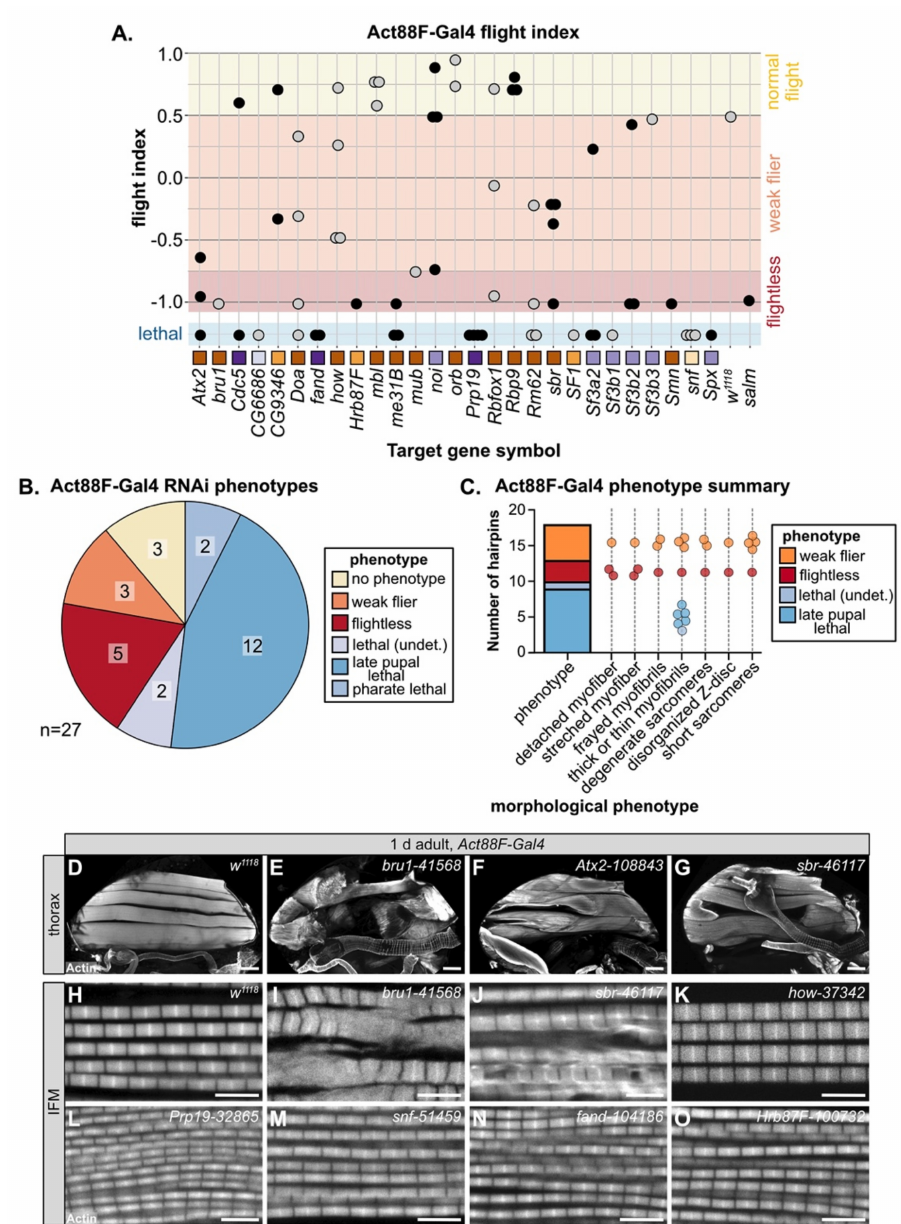
Figure 4. Temporally restricted knockdown of RBPs in IFM with Act88F-Gal4 generates assorted myofibril phenotypes. ( A ) Plot summarizing Act88F-Gal4 phenotype for 65 hairpins targeting 27 RBP genes. Dots represent individual hairpins organized into columns by gene, as labeled. Squares indicate spliceosome membership and are colored as in Figure 2A. Plot background color marks normal flight (yellow), weak/impaired flight (orange), flightless (red) and lethal (blue) phenotypes. ( B ) Pie chart summary of RBP gene-level (strongest hairpin) phenotype when crossed to Act88F-Gal4, which drives in IFM from 24 h APF. (C) Graphical summary of confocal phenotypes from 27 hairpins in ( B ). Dots represent hairpins and are colored by flight (flightless, red; weak flier, orange) and lethality (blue shades) phenotype. Hairpins may appear in more than one morphological phenotype category. ( D – G ) Confocal Z-projection images showing myofiber phenotypes in 1 d adult flies, including detached or torn myofibers (yellow arrow heads in E , G ) and stretched (yellow arrows in F ) myofibers. Scale bars = 100 µ m. ( H – O ) Single-plane confocal images of 1 d adult IFM myofibril and sarcomere structure. RBP knockdown results in diverse phenotypes, such as frayed ( J ) or thin ( L – O ) myofibrils as well as degenerate ( I ) or short ( I – K ) sarcomeres. Scale bars = 5 µ m; phalloidin stained F-actin,